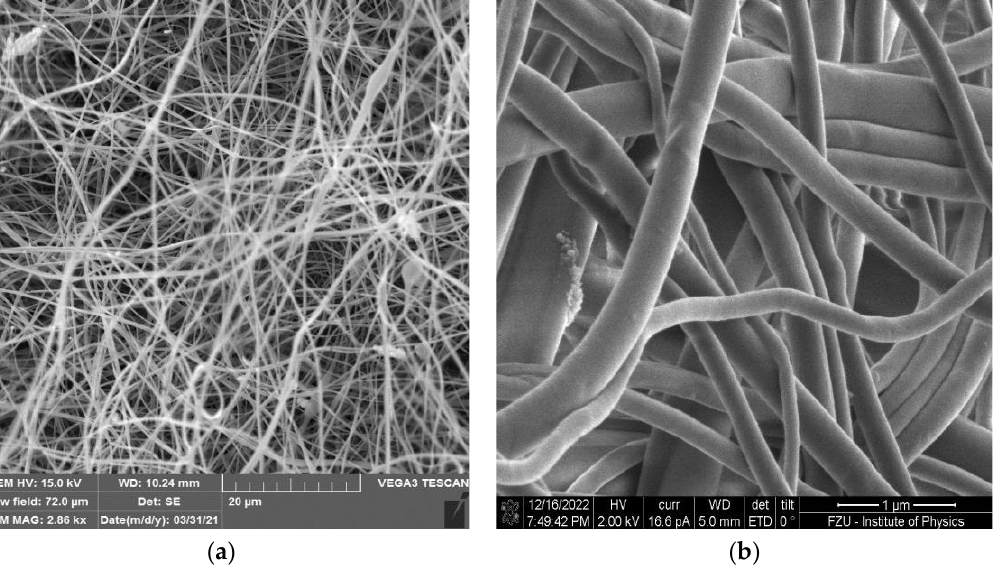
Figure 3. The SEM micrographs of PBI electrospun membrane at lower ( a ) and higher ( b ) magnifi- cation.